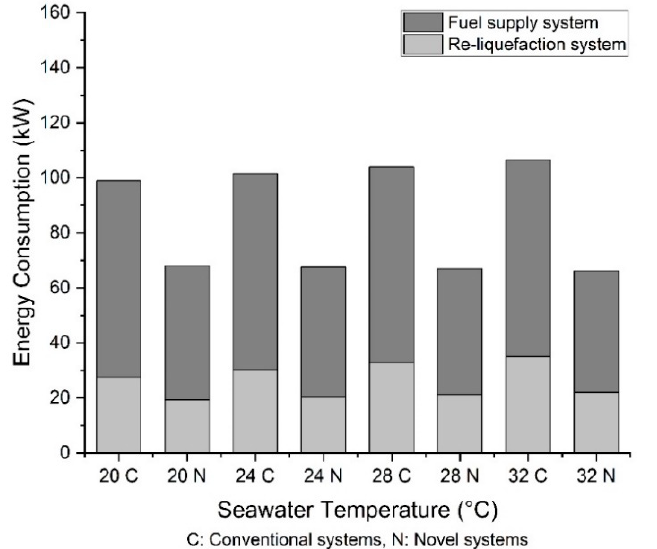
Figure 7. Energy consumption for conventional and novel re-liquefaction and fuel supply systems with seawater temperature.